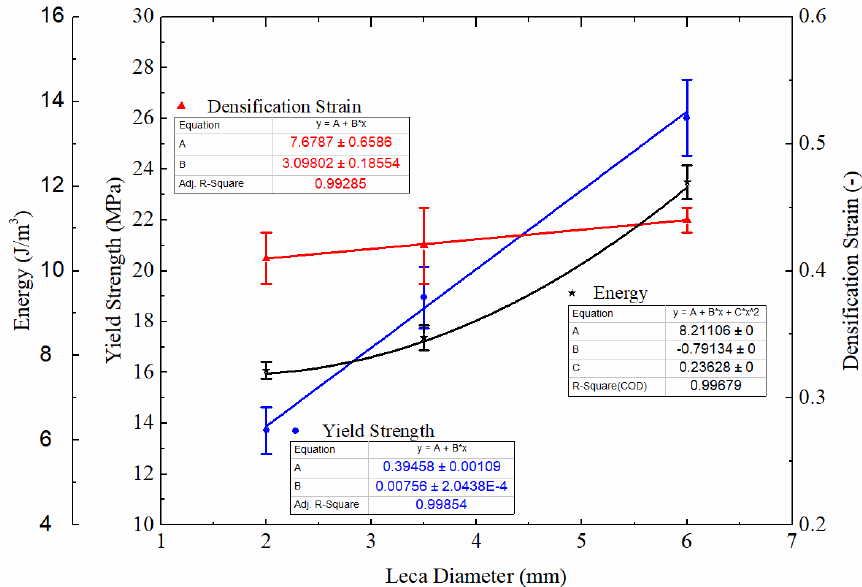
Figure 9. Detailed results of the uniaxial compression testing.